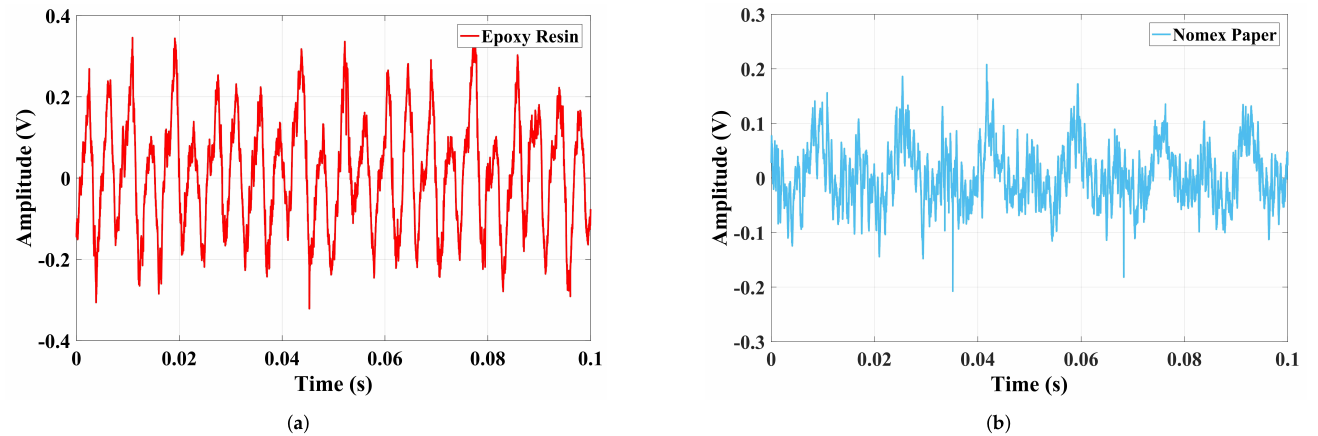
Figure 4. Time domain signals extracted from PDs in ( a ) epoxy resin and ( b ) Nomex paper.